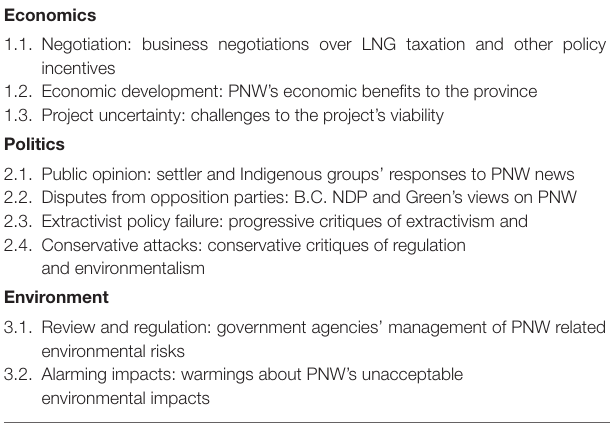
TABLE 2 | Coding scheme of news